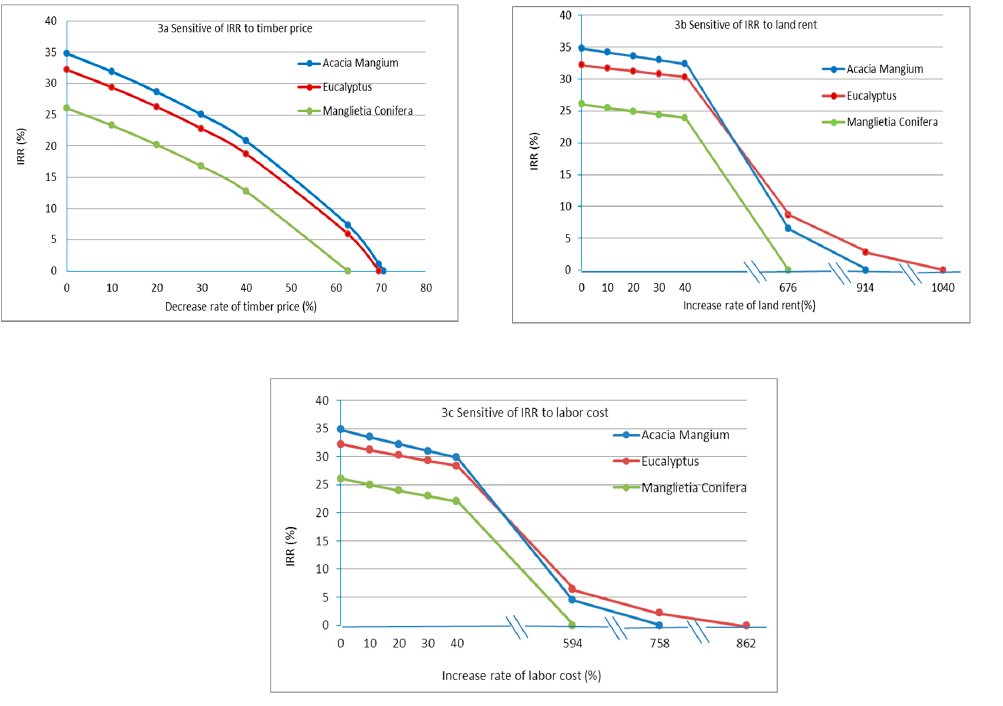
Figure 3. Sensitivity of IRR to timber price (3 a ); land rent (3 b ); and labor cost (3 c ).